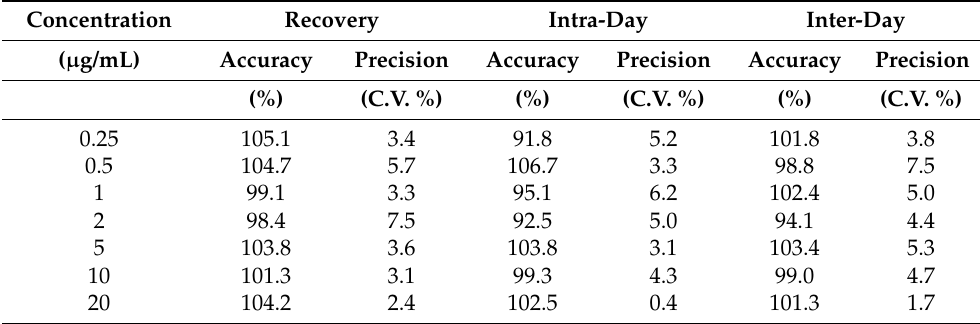
Figure 6. Chromatograms of DLZ obtained from ( A ) plasma free of DLZ and ( B ) plasma spiked with10 µg/mL DLZ (Reprinted from ref. [46]). Table 4. Extraction recovery, Intra-day and Inter-day accuracy and precision of the HPLC validation for the DLZ in plasma, ( n = 6).